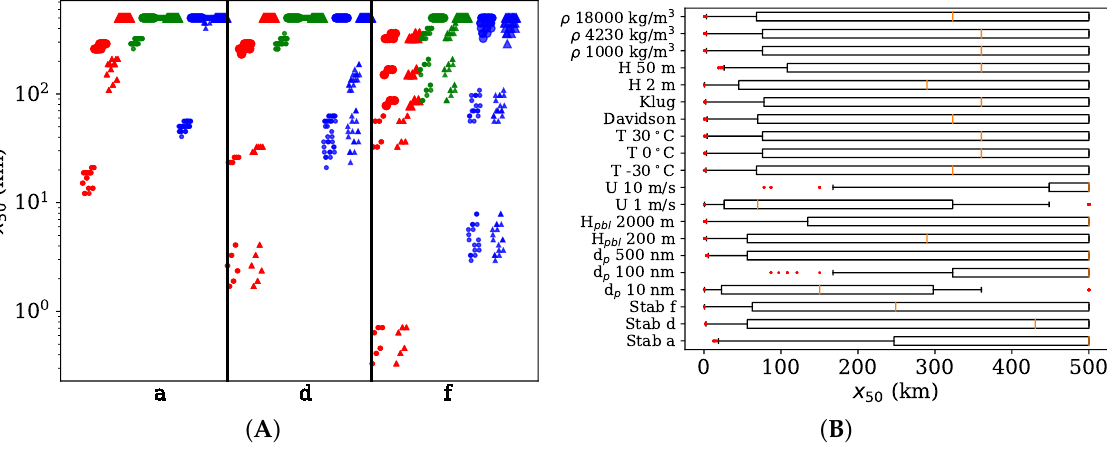
Figure 3. The x 50 distances for ENM simulations. ( A ) All data points grouped for the atmospheric stability classes (a, d, f). Circles correspond to the boundary layer height of 0.2 km and triangles the height of 2 km. Red markers have a particle size of 10 nm, green a size of 100 nm and blue a size of 500 nm. Smaller marker sizes represent the wind speed of 1 m/s and larger markers the speed of 10 m/s. ( B ) Sensitivity of the input parameters. The yellow line represents the median value of all observations for a certain parameter value. The boxes present 25 and 75% quartiles, while the whiskers correspond to the 5th and 95th percentiles. Red dots are